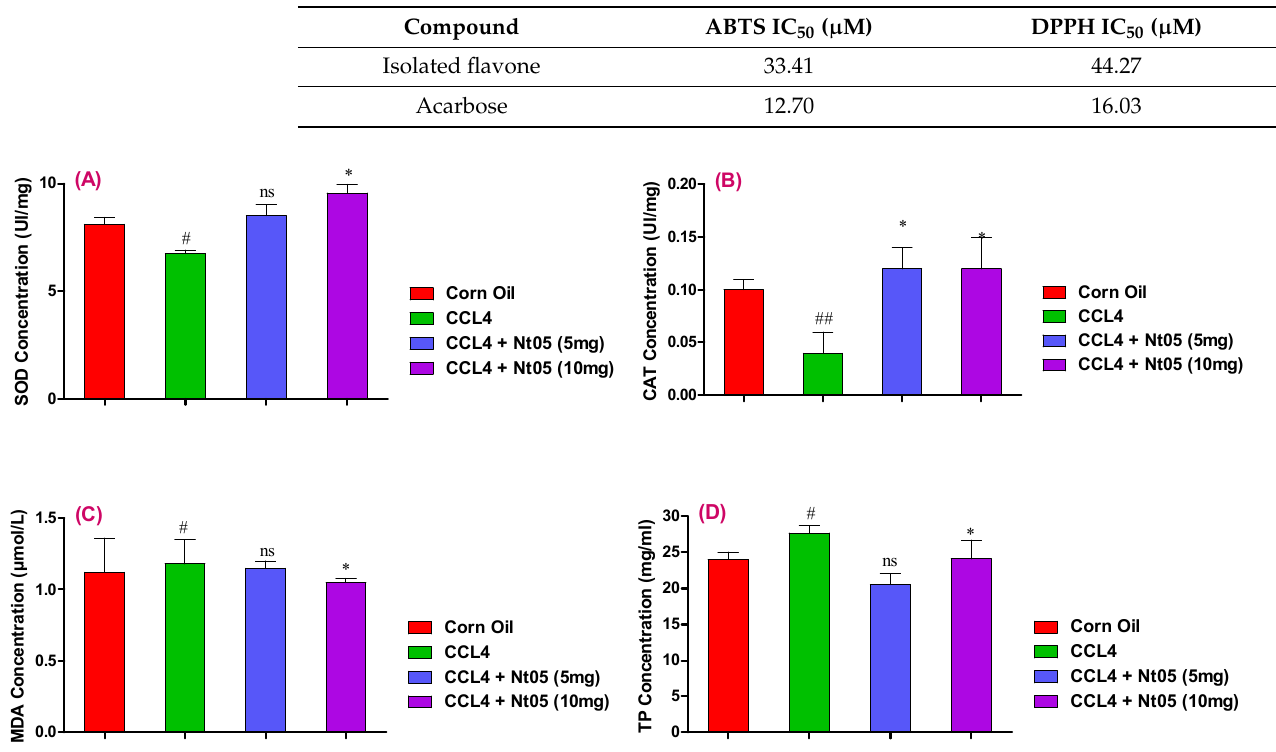
Figure 2. Percent inhibition produced by tested compound (10 mg/kg) in carrageenan induced inflammation. Data (Mean ± SEM) were analyzed by TWO-WAY Annova followed by Bonferroni post test. ### Displayed comparison of the standard drug aspirin to the vehicle while asterisk represents comparison of tested and standard drug, ### p < 0.001, * p < 0.01,ns; not significant. Table 3. In-vitro antioxidant activity of the isolated flavone.